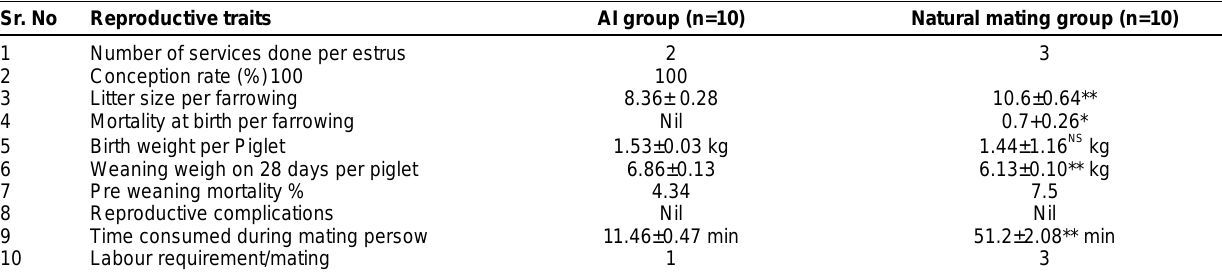
Table-1. Results of the reproductive performance of sows bred by natural mating and AI Sr.